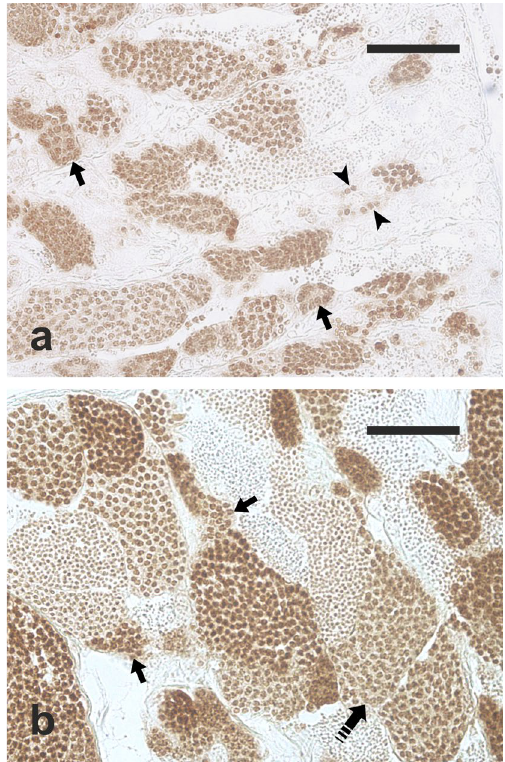
Figure 5. Micrographs of testis sections of ( a ) a juvenile meagre treated with saline solution for 6 weeks (CONTROL 6 group) and ( b ) a juvenile fish treated with rFsh for 6 weeks (TREATED group), immunostained with antibodies against the proliferating cell nuclear antigen (PCNA), which stains brown the nuclei of proliferating cells. Magnification bars = 50 μm. Arrowhead = anti-PCNA–positive single type A spermatogonium; arrow = anti-PCNA–positive spermatogonial cyst; dashed arrow = anti-PCNA–positive primary spermatocyte